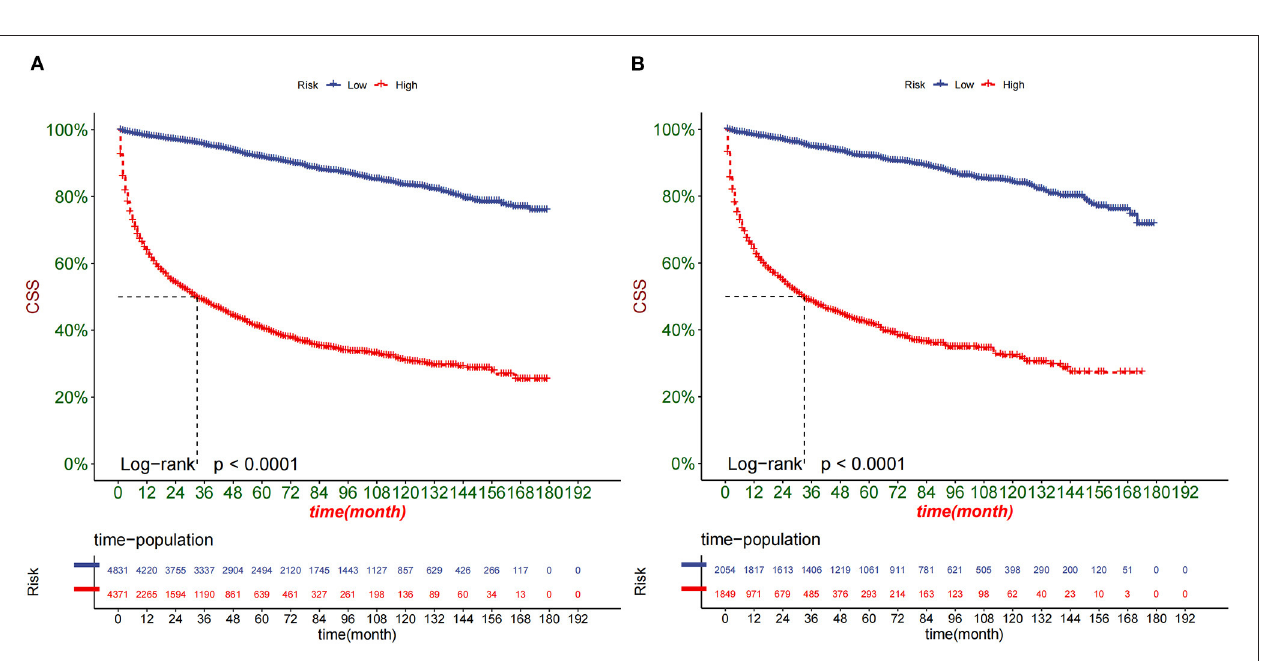
FIGURE 6 | Kaplan-Meier curves of patients in the low-risk and high-risk groups in the training cohort (A) and the validation cohort (B) .